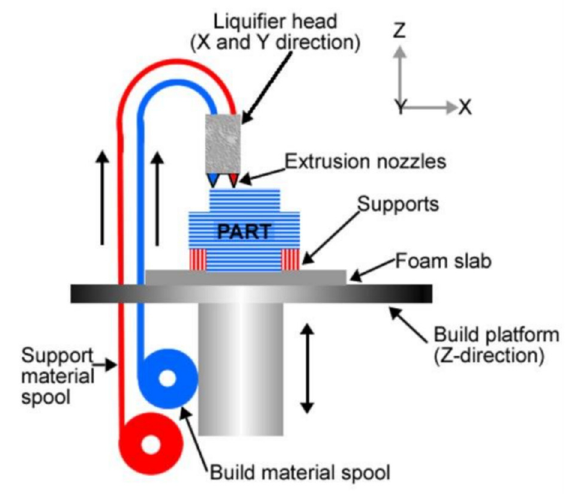
Figure 1. Overview of FDM process.